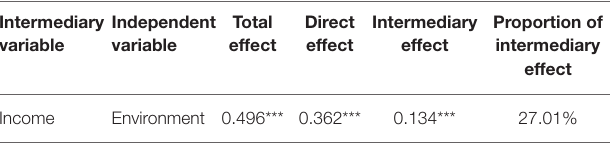
TABLE 3 | Analysis of the intermediary effect of residents’ income on environmental factors and physical activities. Intermediary